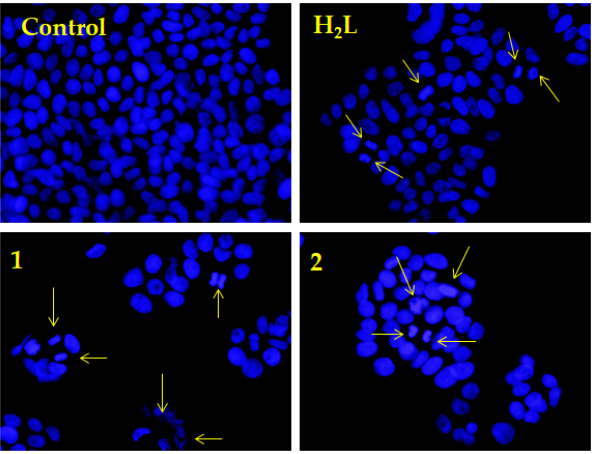
Figure 7. Study of apoptosis by morphological changes in nuclei of HT-29 cells. Arrows show the morphological changes in the nuclei of HT-29 cells observed on applying H 2 L, 1 , and 2 in comparisons to control.